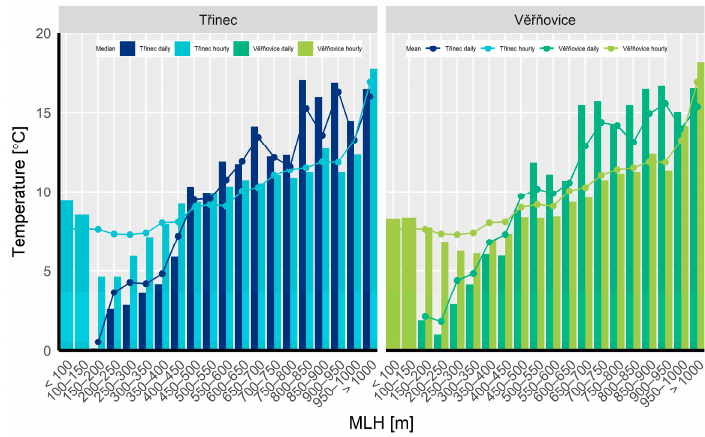
Figure 7. Mean and median temperature values at mean and median MLH values, T ř inec-Kosmos, V ěřň ovice, 2016–2019.